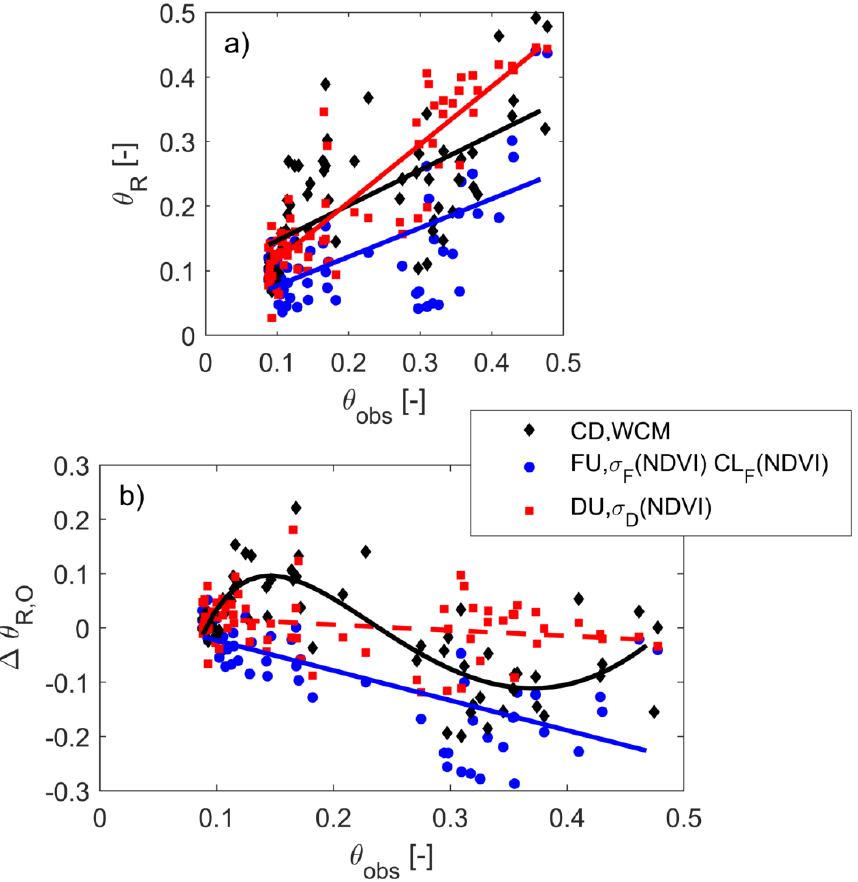
Figure 6. At the grass field for the 2016–2017 period: ( a ) comparison of soil moisture estimates from Sentinel 1 ( θ R ) using the CD method with WCM (CD,WCM), the DU method with the proposed σ D (NDVI) relationship (DU, σ D (NDVI)), and the FU method with the proposed σ F (NDVI) and CL F (NDVI) relationships (FU, σ F (NDVI), CL F (NDVI)) with measured soil moisture at the field ( θ obs ) (regressions dashed lines are: θ CD,WCM = 0.55 θ obs + 0.09 with R 2 = 0.45 and p < 0.01, θ DU = 0.90 θ obs + 0.02 with R 2 = 0.80 and p < 0.01, θ FU = 0.45 θ obs + 0.03 with R 2 = 0.41 and p < 0.001, respectively); ( b ) differences between θ R and θ obs ( Δ θ R,o ) versus θ obs (regression dashed lines are: Δ θ CD,WCM,o = ( − 7.83 × 10 3 θ obs 4 + 3.55 × 10 4 * θ obs 3 − 2.52 × 10 4 * θ obs 2 + 5385 θ obs − 307.4)/( θ obs 2 + 2106 θ obs + 194.4) with R 2 = 0.65 and p < 0.001, Δ θ DU,o = 0.10 θ obs + 0.02 with R 2 = 0.05 and p = 0.06, Δ θ FU,o = − 0.55 θ obs + 0.03 with R 2 = 0.51 and p <